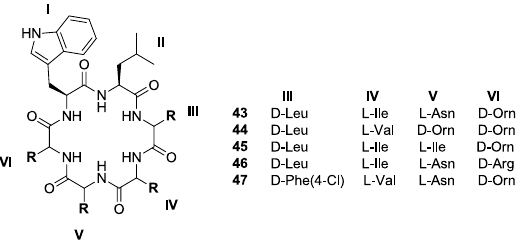
Figure 8. Structures of cyclohexapeptides 43 – 47 .